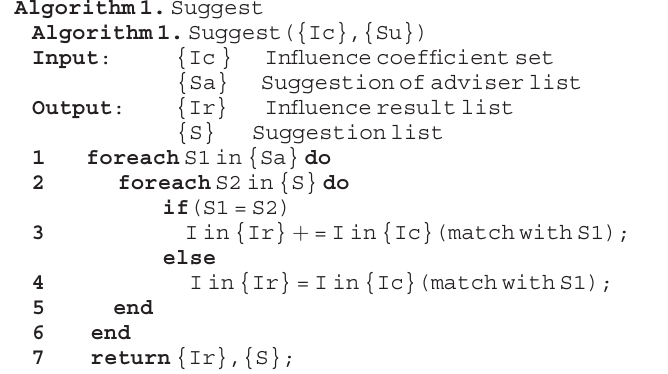
Algorithm 1. Suggest({Ic},{Su})